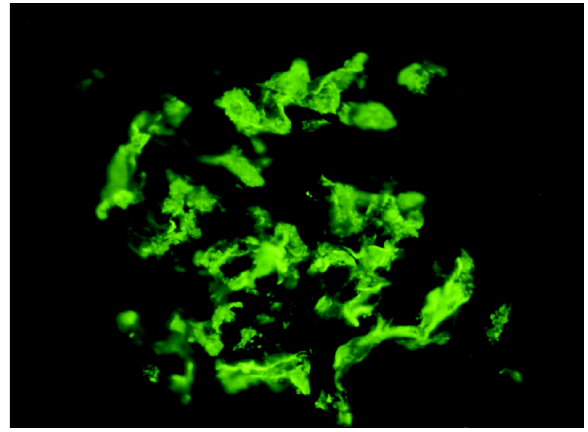
Figure 1 – Histological study showing positive glomerular stain- ing (direct immunofluorescence,